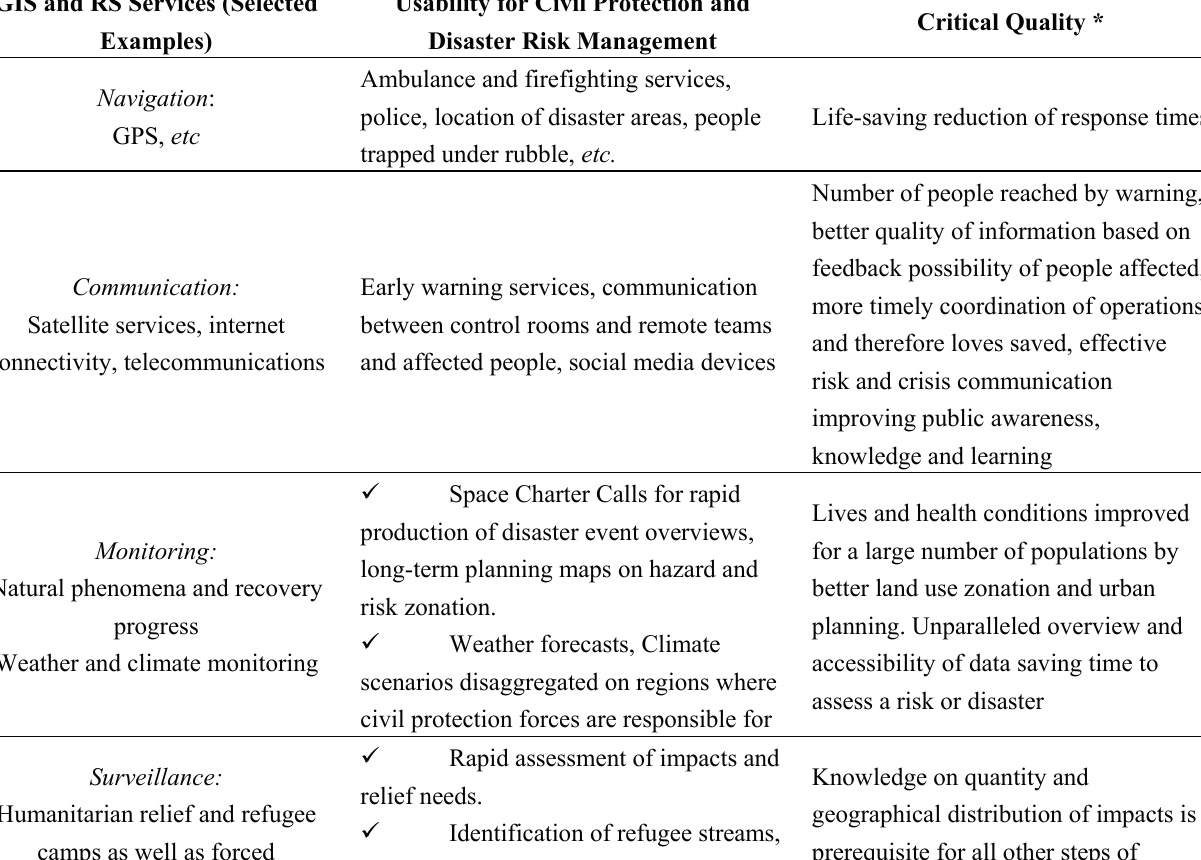
Table 1. Usefulness and critical infrastructure characteristics of selected GIS and RS services for civil protection and disaster risk management/governance. GIS and RS Services